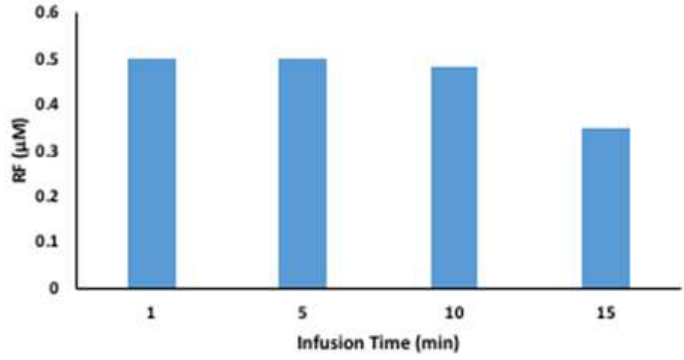
Figure 1. Riboflavin amount in hot water vs. infusion time.